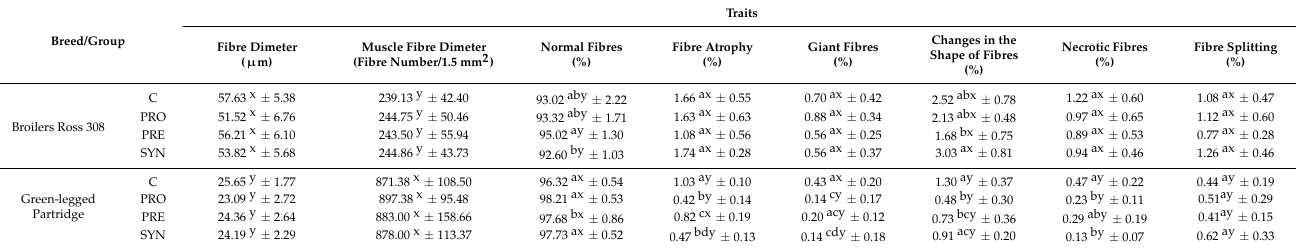
Table 3. Microstructural features and the percentage (%) of normal and pathological fibres in the superficial breast muscles from 42-day-old Ross 308 broiler chickens and green-legged partridge (GP) chickens injected in ovo with bioactive substances on day 12 of embryonic development (means ±